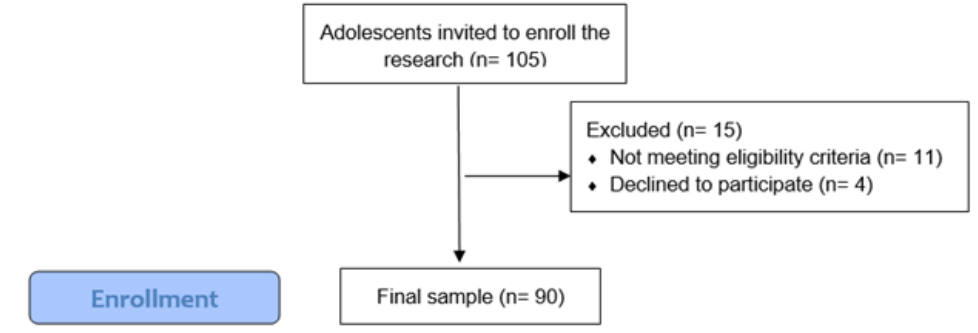
Figure 1. Participants recruitment flowchart.